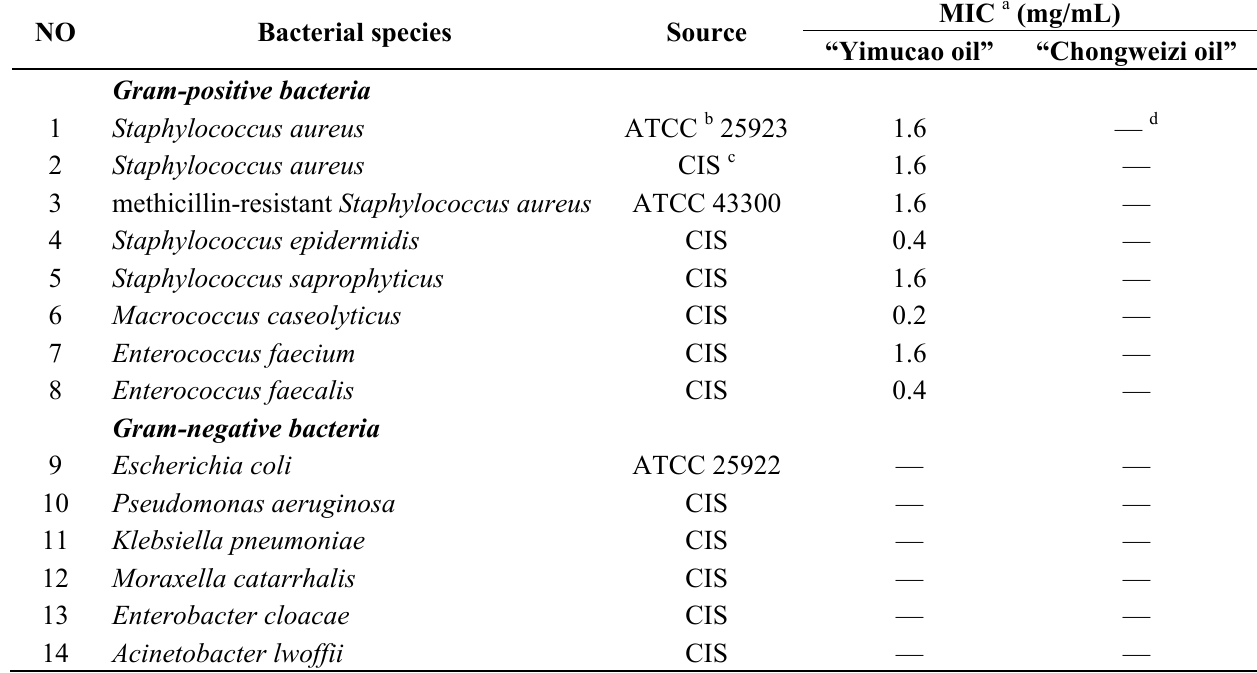
Table 1. Antibacterial activity of “Yimucao oil” and “Chongweizi oil”.